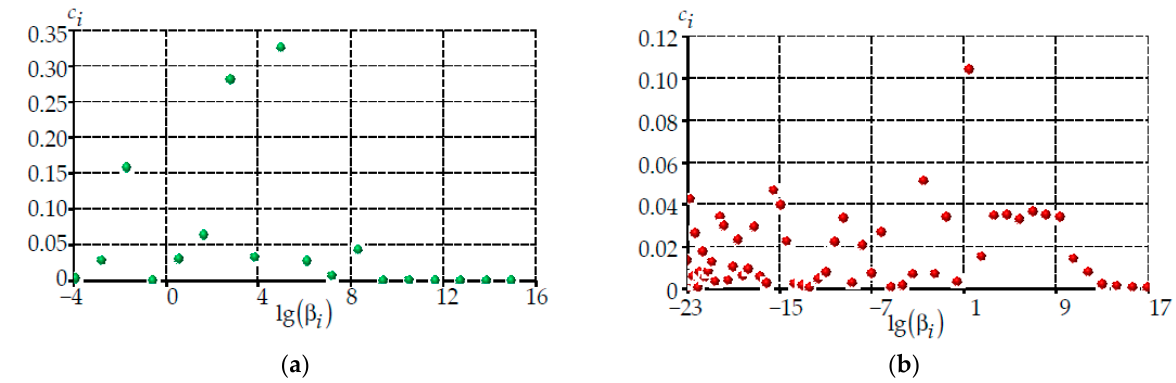
Figure 2. Prony series for polymeric protective coatings: ( a ) is material 5; ( b ) is material 6.